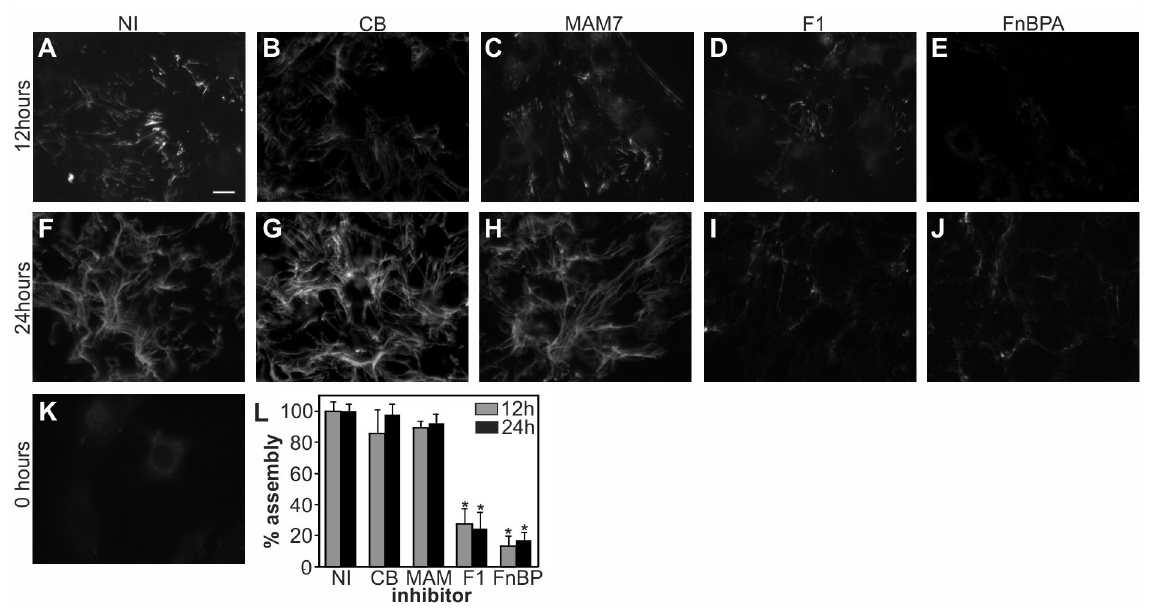
Figure 7. Influence of adhesion inhibitors on in vitro matrix formation. Incorporation of rhodamine-labelled fibronectin into the extracellular matrix of fibroblasts was visualized by fluorescence microscopy, after 12 or 24 hours of incubation in medium alone (NI, A, F) or medium containing immobilized GST (CB, B, G), MAM7 (C, H), F1 (D, I) or FnBPA (E, J) derived peptides. Background fluorescence of unlabelled cells at t=0 hours (K). Scale bar, 10 μm. Images are representative of a set of three experiments, with at least three frames taken per replicate. Incorporation of rhodamine-fibronectin into the extracellular matrix in medium alone (NI) or medium containing immobilized GST (CB), MAM7, F1 or FnBPA derived peptides was quantified after 12 hours (grey) and 24 hours (black) incubation using fluorescence plate assays (L). Values significantly different from the control (p<0.01 according to student t- test) are indicated